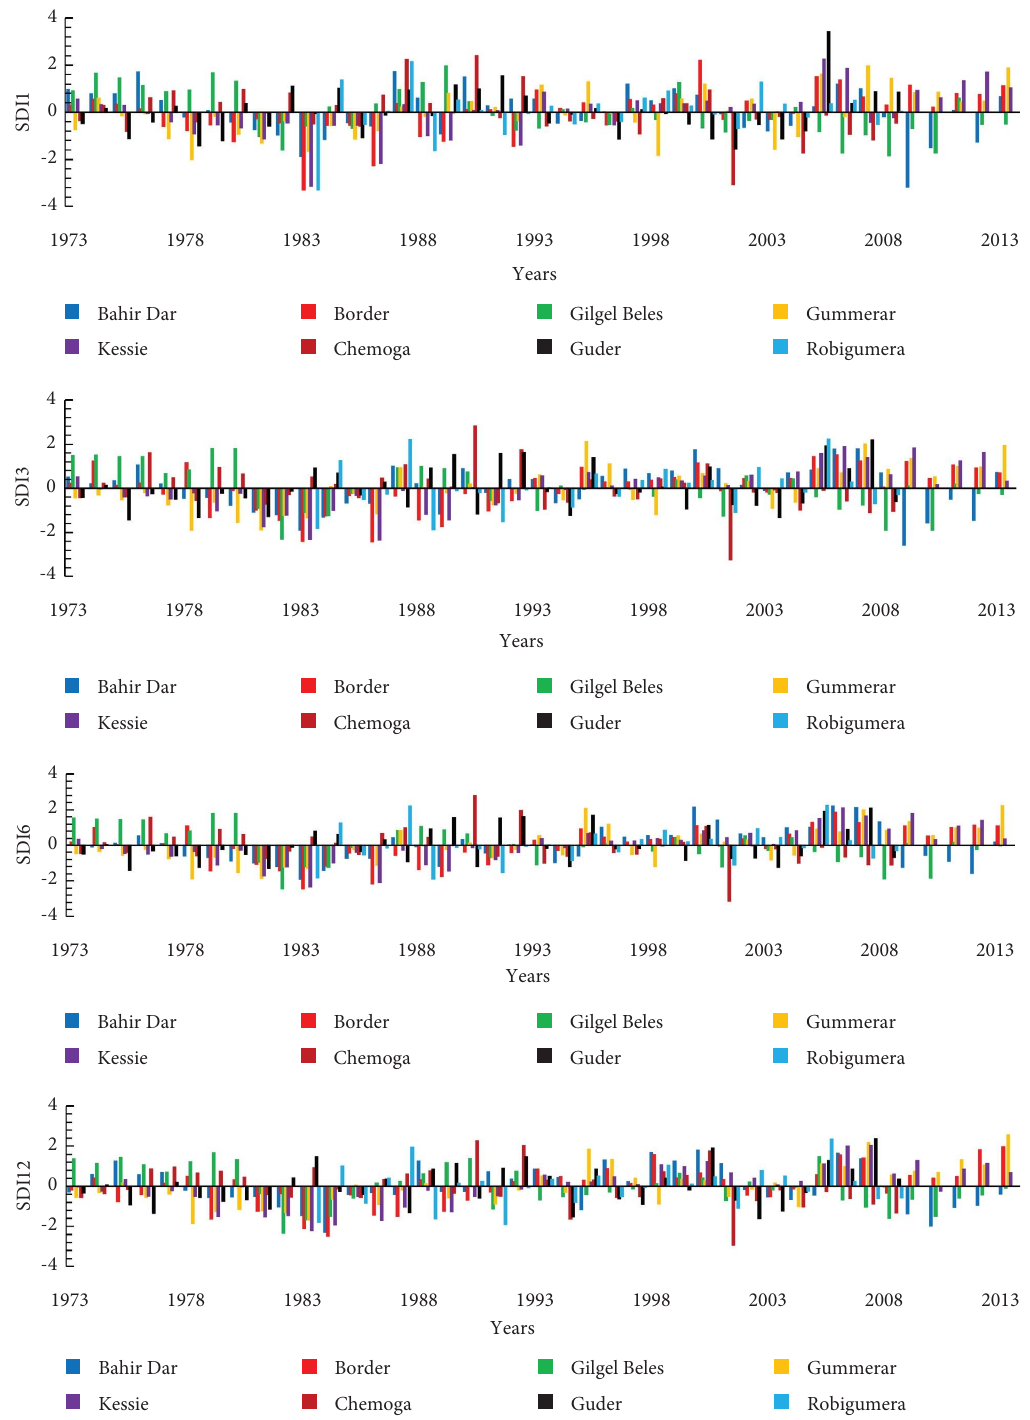
Figure 6: Hydrological drought (SDI) time series in Abbay river